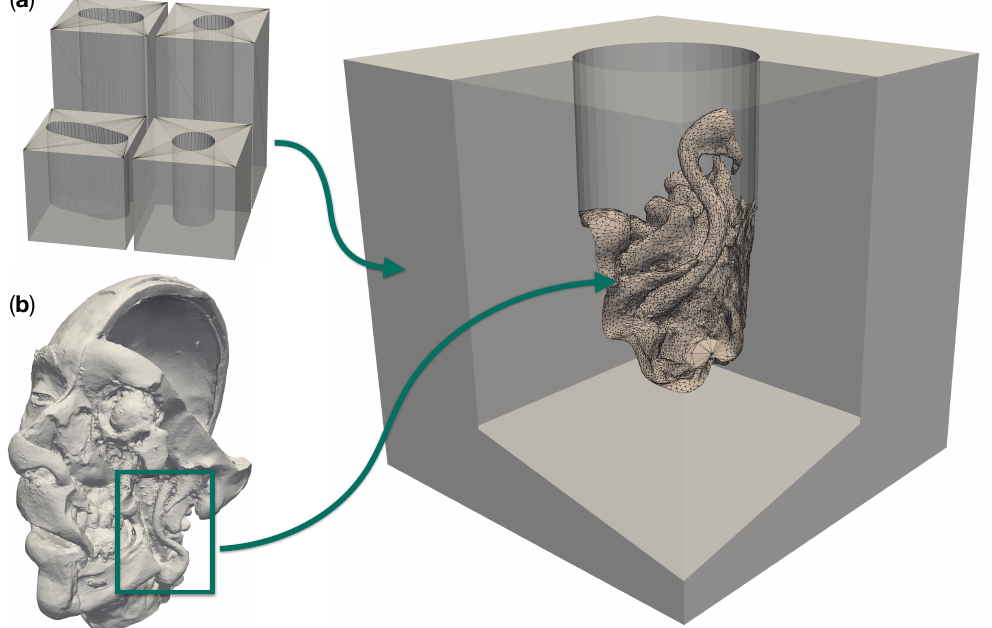
Figure 1. Design components for a realistic site models with a patient anatomy in a deep operative corridors. ( a ) shows the four different operative corridors used: Two cylindrical channels with a depth of 50mm and 100mm, respectively, as well as two channels of the same depths with a deformed elliptical cross-section. ( b ) Three-dimensional model of a plastinated and dissected human head. The box highlights the region which was merged into an empty cylindrical channel to create the particular model to the